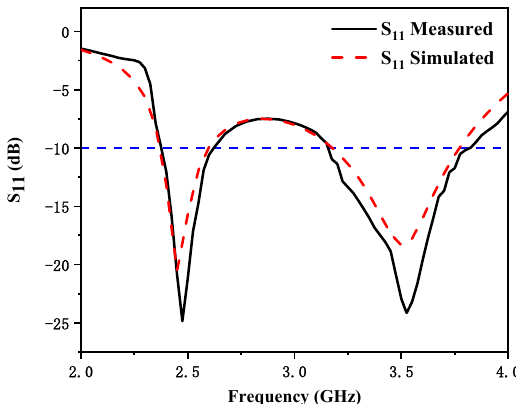
Figure 5. Simulated and measured S 11 of the proposed antenna.